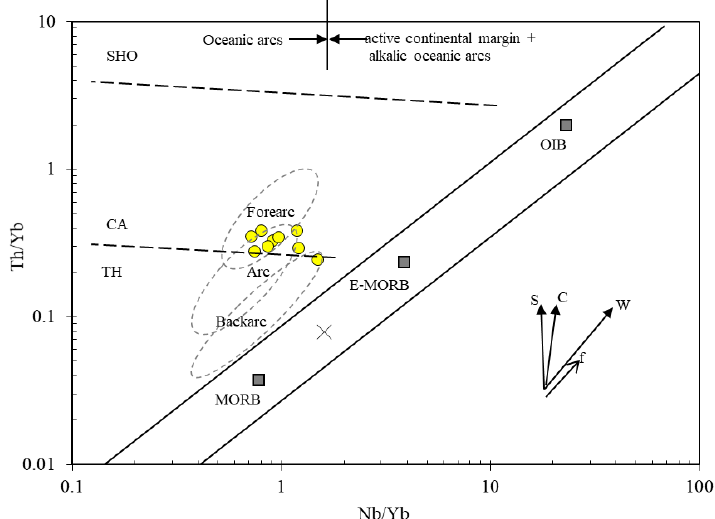
Figure 8. Tectonic discrimination diagram of Nb/Yb vs. Th/Yb after Pearce [30]. The dashed field boundaries for TH = tholeiitic, CA = calc-alkaline, and SHO = shoshonitic rocks are from convergent margins. The bold arrows in the bottom right are S = subduction component, C = crustal contaminant component, W = within plate, and f = fractional crystallization vectors. The Holenarsipur boninites plot sub-parallel to the terrestrial MORB – OIB array, and within the Phanerozoic arc fields. The Phanerozoic arc, fore-arc, and back-arc basalt fields are from Metcalf and Shervais [31]. Symbols are same as in Figure 5. See text for details.